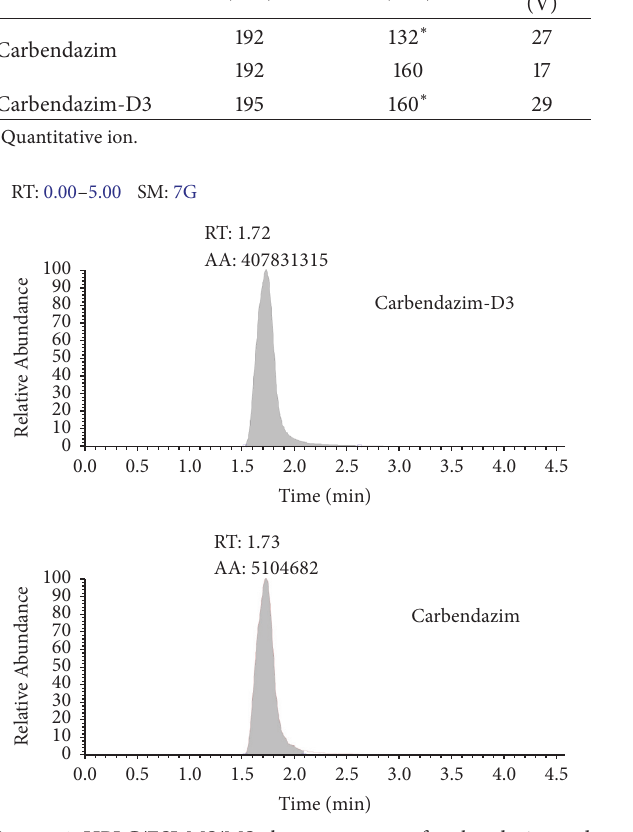
Figure 1: HPLC/ESI-MS/MS chromatograms of carbendazim and carbendazim-D3 in the standard